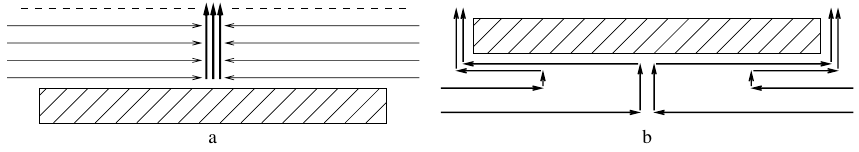
Figure 1. ( a ) flow above a heated plate; ( b ) flow below a heated plate.